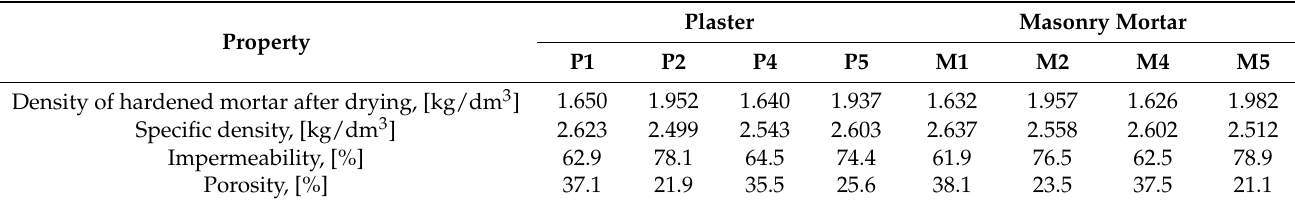
Table 7. Porosity and impermeability of